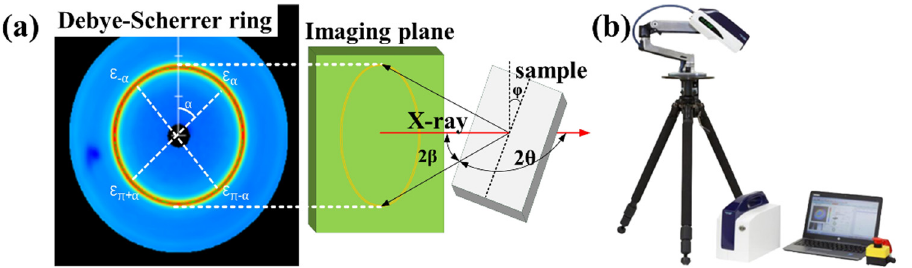
Figure 3. Principle and equipment of X-ray residual stress measurement: ( a ) Schematic diagram of the calculation principle of residual stress measurement based on the cos α method; ( b ) X-ray testing equipment.